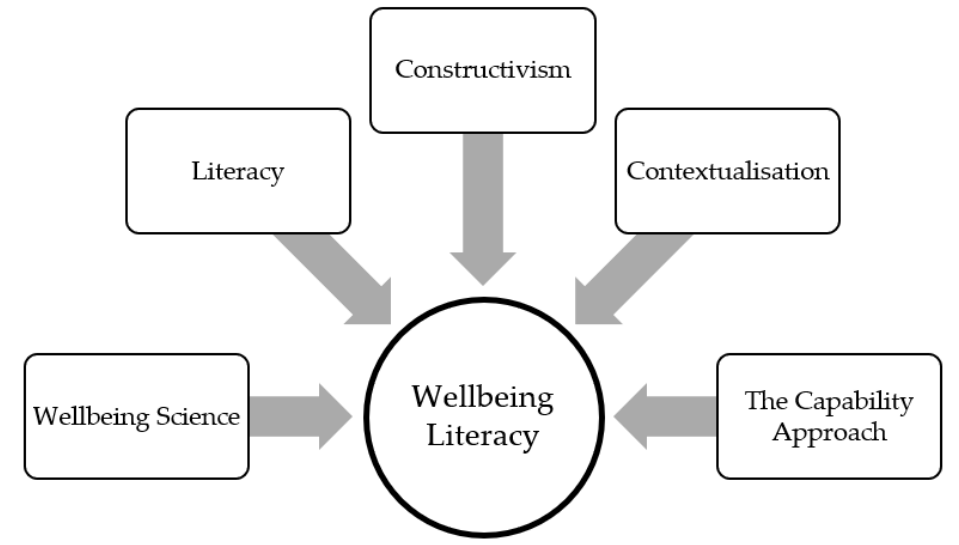
Figure 1. Intellectual and disciplinary contributions to the concept of wellbeing literacy.